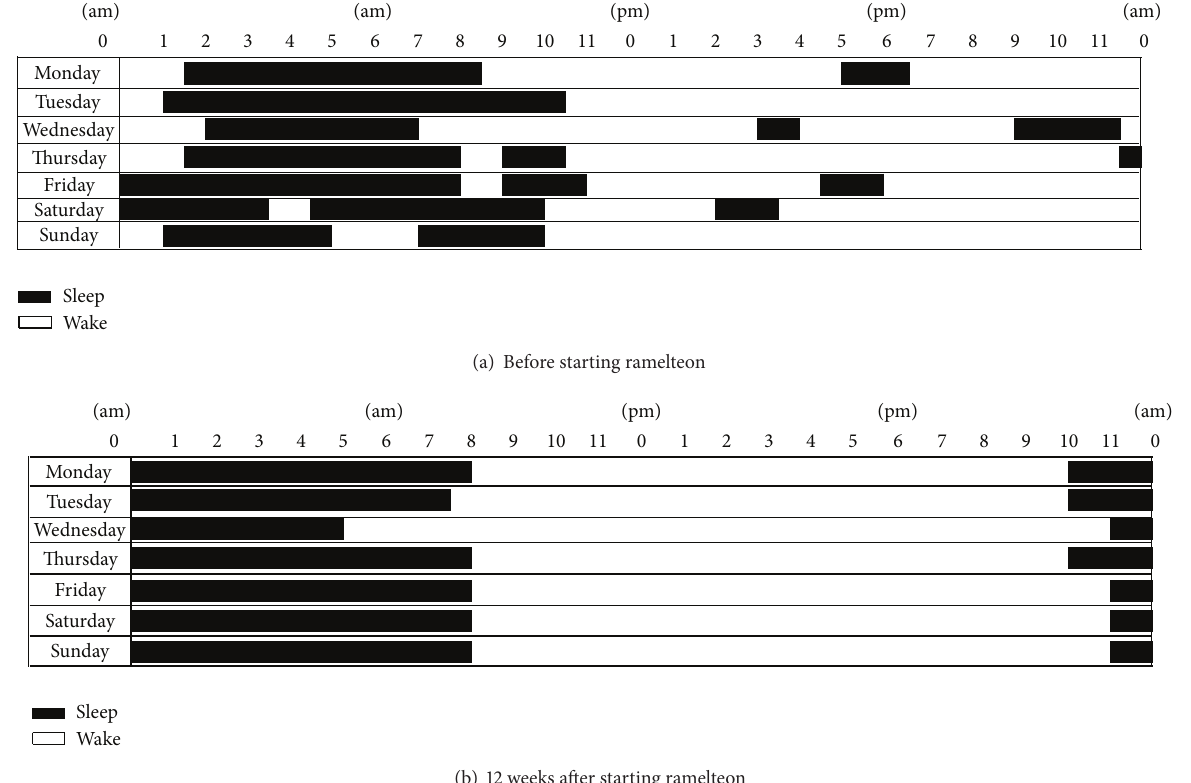
Figure 2: Sleep diaries of Case